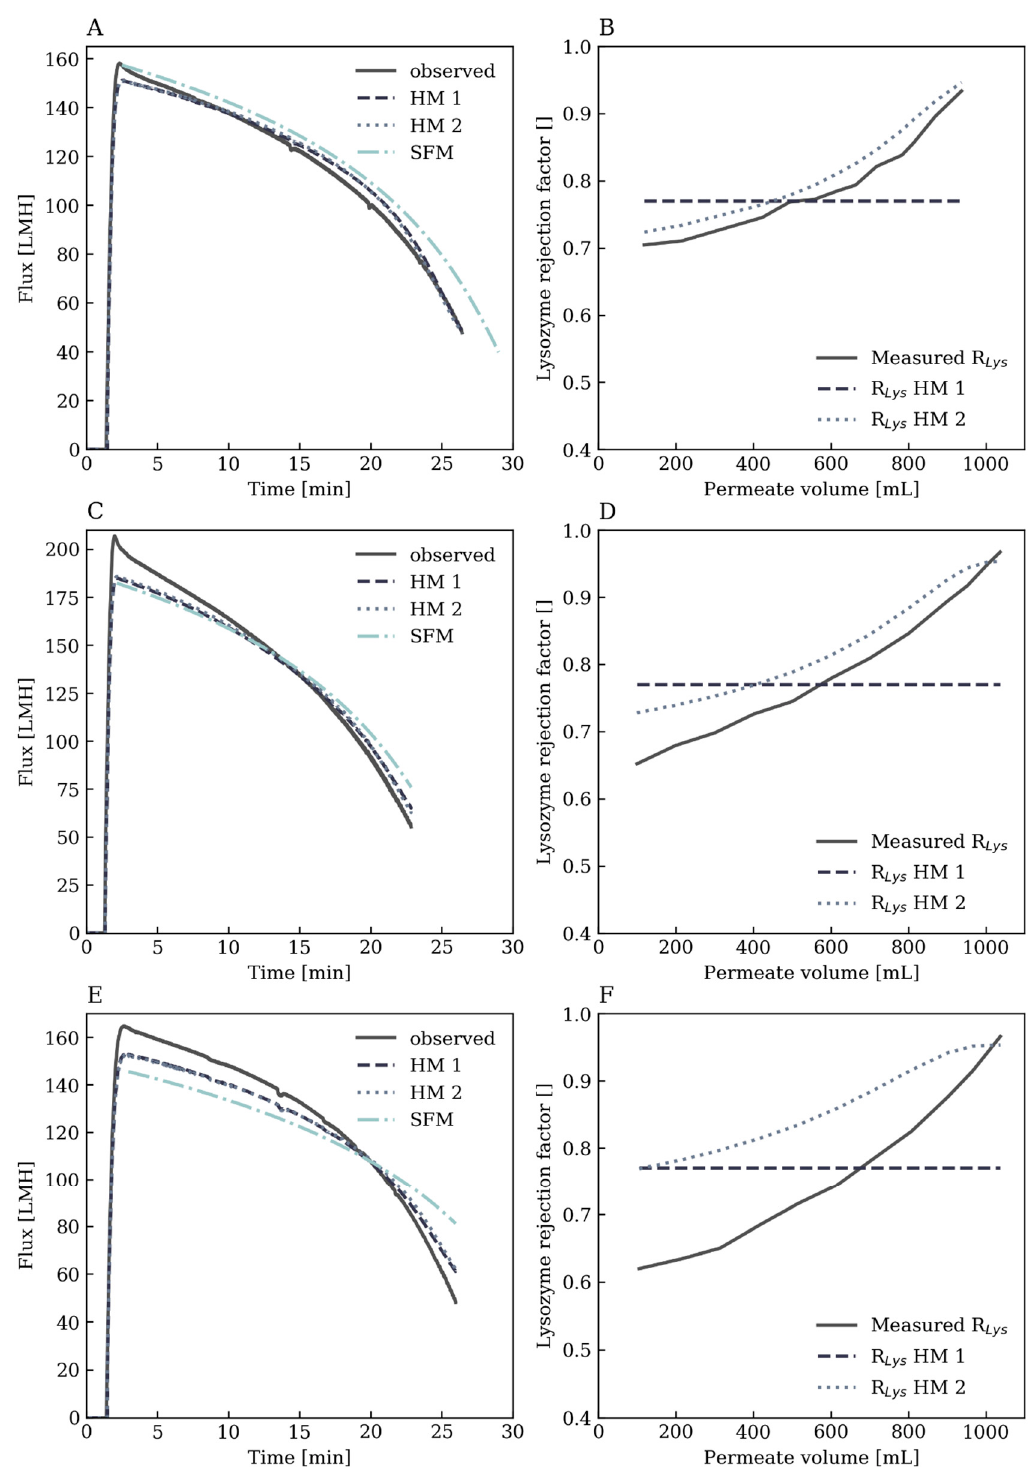
Figure 6. Comparison of observed and predicted flux and R Lys . ( A ) The flux over time of test run 1, ( B ) R Lys over permeate volume of test run 1, ( C ) the flux over time of test run 4, ( D ) R Lys over permeate volume of test run 4, ( E ) the flux over time of test run 5, ( F ) R Lys over permeate volume of test run 5.